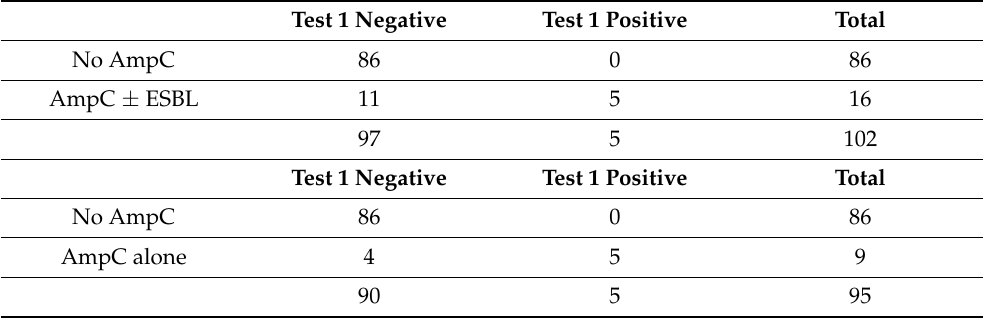
Figure 2. Screening method for the phenotypic detection of AmpC . ( A ): Image of test 1, depicting the synergy between the large white disk with CLX (20 µL at concentration of 50 mg/mL) and ETP and FEP susceptibility halos. ( B ): Image of test 2, depicting the same synergy phenomenon as in A, but in this case between the oxacillin disk with CLX (10 µL at concentration of 50 mg/mL) and ETP and FEP disks. CLX (cloxacillin); ETP (ertapenem); FEP (cefepime); FOX (cefoxitin). Table 6. Detection of isolates with AmpC using test